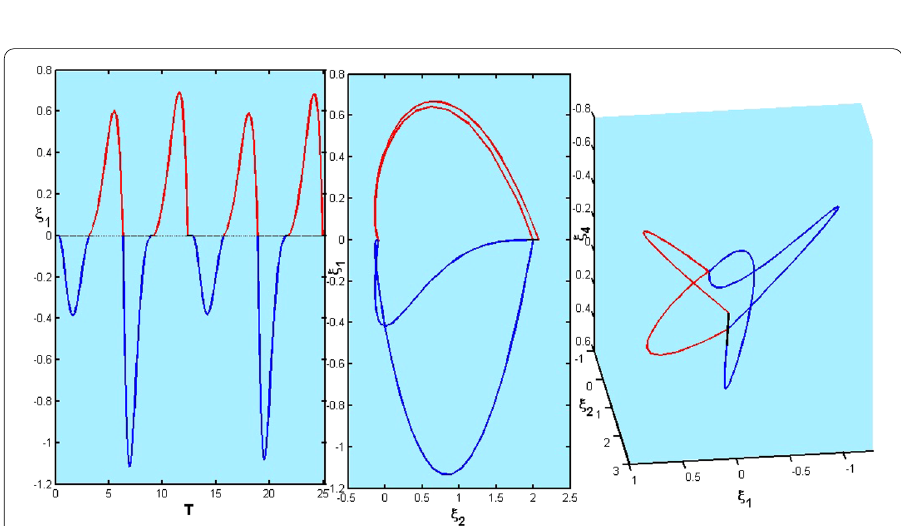
Figure 6 Period-two orbit with a segment of sliding motion established by ¯ ξ ∈ M 0 – when ¯ ξ 4 = 0, β – = 2, K =